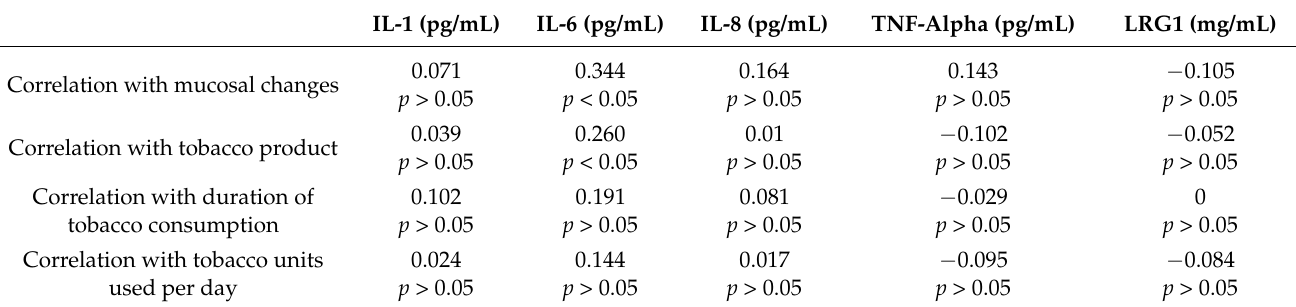
Table 5. Association between mucosal changes and oral